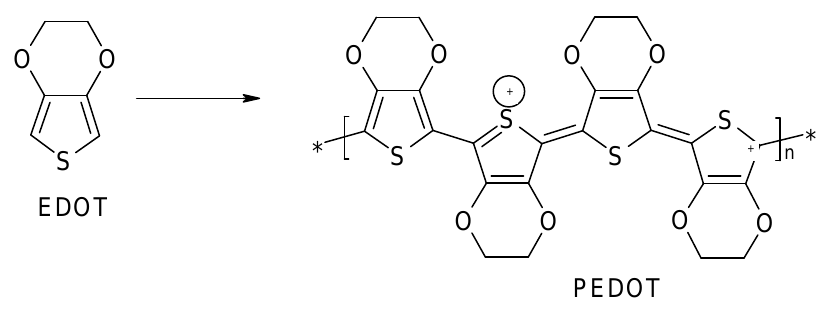
Figure 10. Formation of PEDOT.